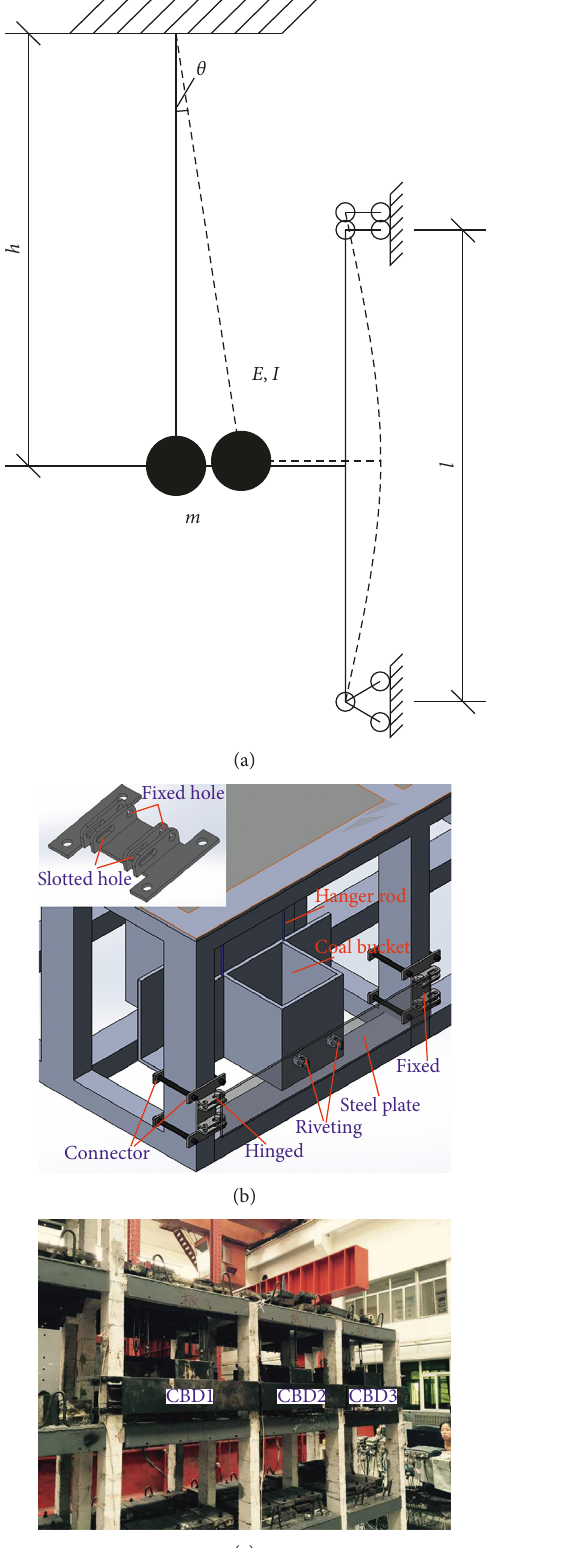
Figure 7: Coal bucket dampers used in the shaking table test model. (a) Simplified mechanical model of a CBD. (b) Detailed structural drawing of a CBD. (c) Layout of CBDs in test model.